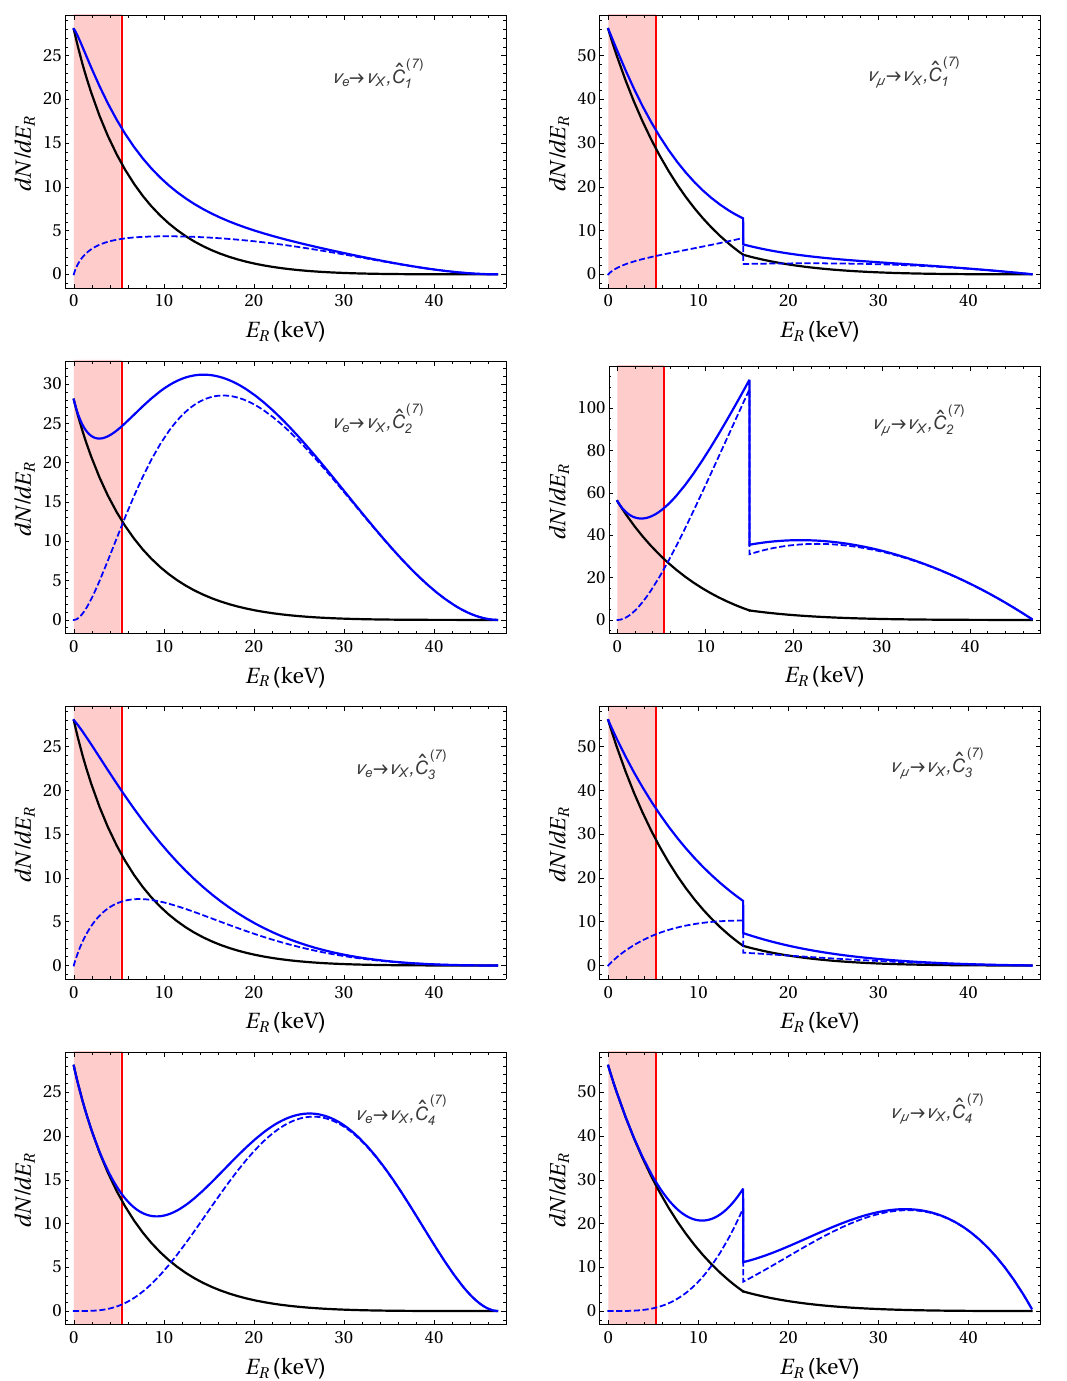
Figure 11 . The ν the presence of NSI operators notation is as in figure